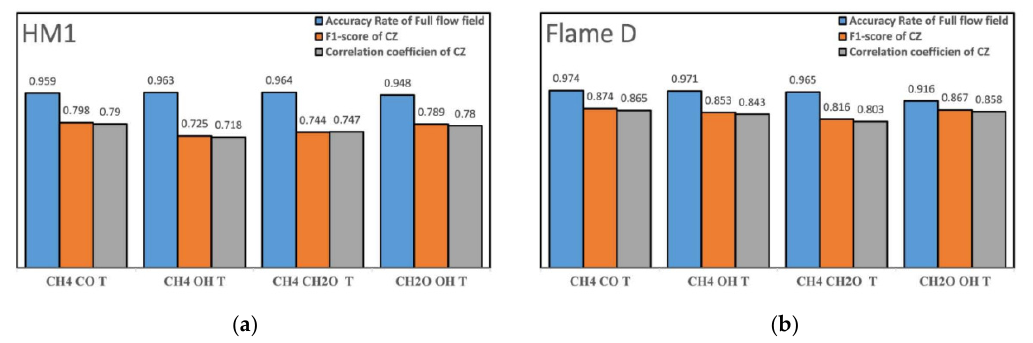
Figure 12. Identification accuracies with three-dimensional BPNN: ( a ) HM1; ( b ) Sandia Flame D.